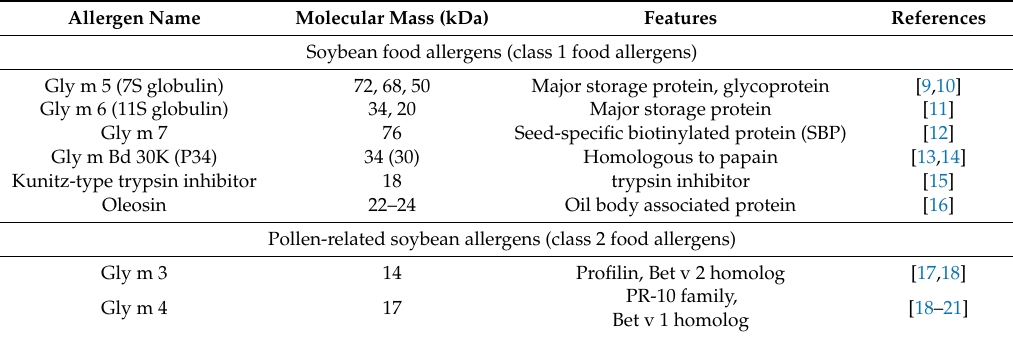
Table 1. Various soybean allergens detected in this